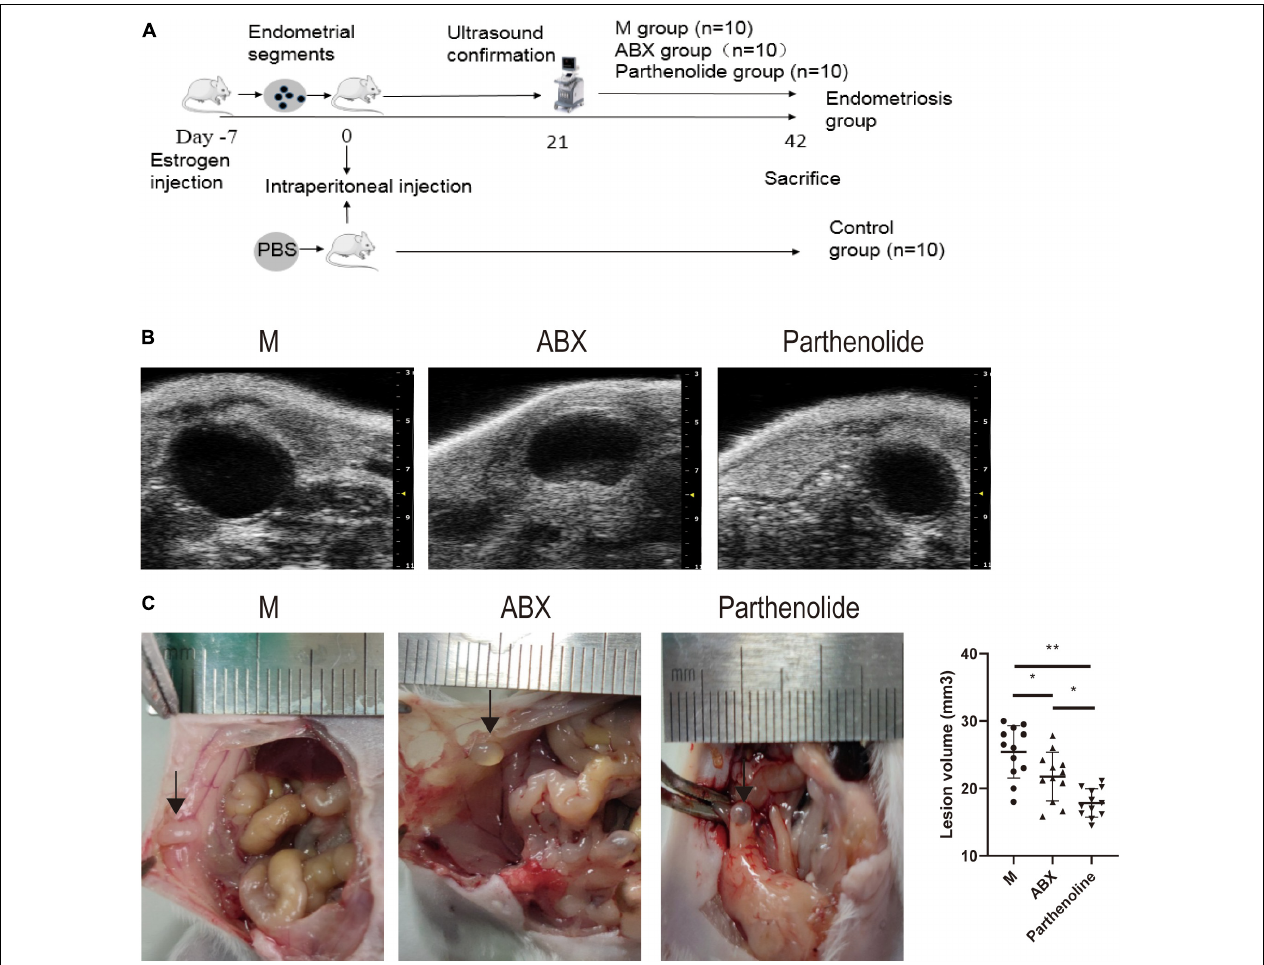
FIGURE 2 | Mixed antibiotics and parthenolide inhibit endometriotic lesion progression. (A) Schematic of experimental timeline and procedures. (B) High-resolution ultrasound confirmed the change in lesion size with treatment. (C) Representative gross images and volumes of ectopic lesions from the indicated treatment groups 3 weeks after established endometriosis confirmed by ultrasound examination. Data are presented as mean ± SE; mock ( n = 10), ABX ( n = 10), and parthenolide ( n = 10). * p < 0.05, ** p < 0.01, and ns, non-signficant.